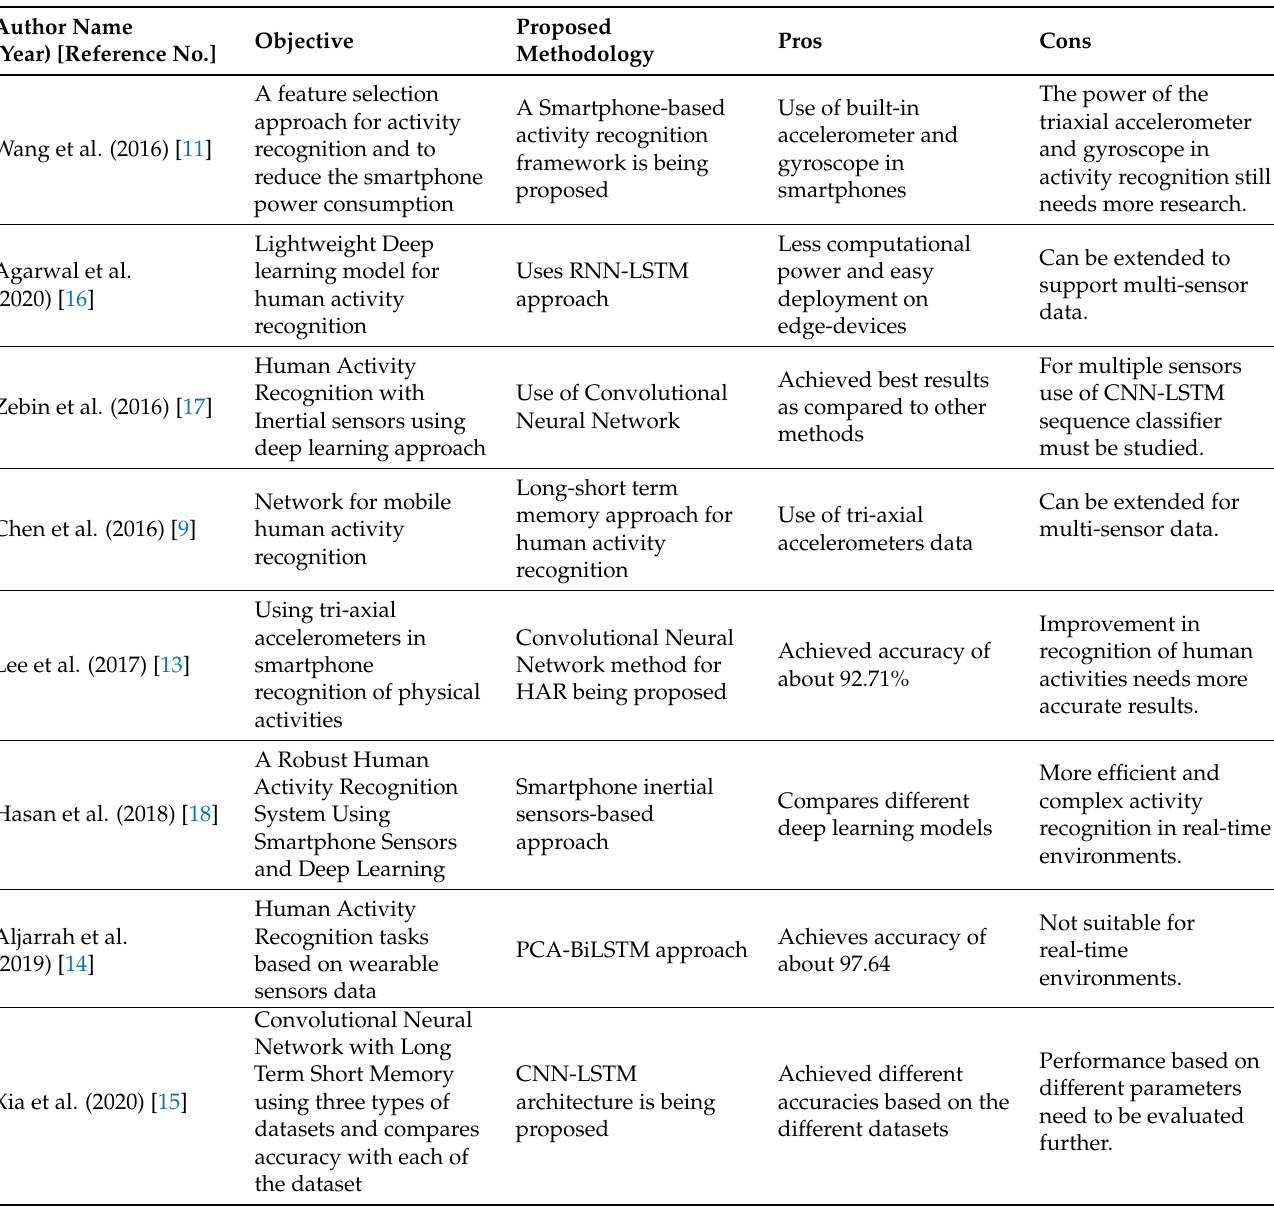
Table 1. Comparative study of existing